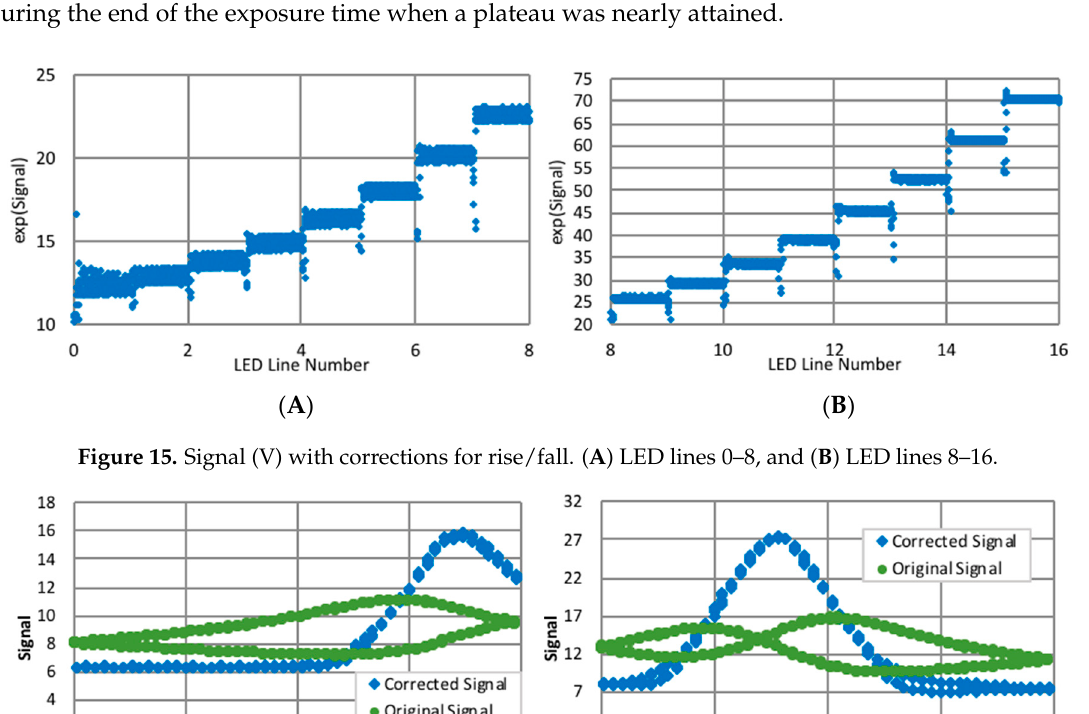
Figure 14. Sample signals (V) for LED lines from ( A ) one entire pass of pseudo-moving target, ( B ) LED lines 0–8, and ( C ) LED lines 8–16.